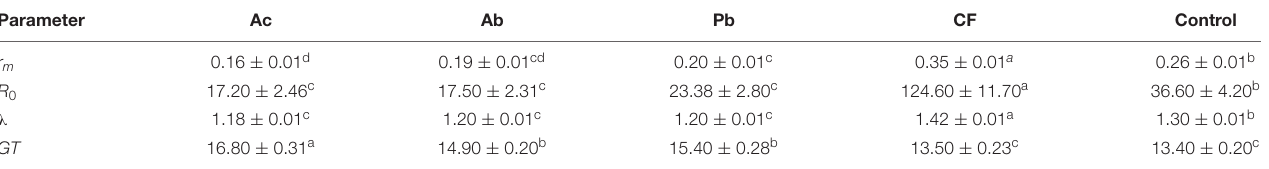
FIGURE 3 | Mean ( ± SE) number of T. urticae (including all mobile developmental stages and adult males and females) per leaf at each weekly sampling interval ( n = 6) on whole strawberry plants receiving one of five treatments, Ac ( Azotobacter chroococcum ), Ab ( Azospirillum brasilense ), Pb ( Pseudomonas brassicacearum ), CF (chemical fertilizer), and control (untreated). TABLE 2 | Mean ( ± SE) demographic parameters of T. urticae calculated using the age-stage, two-sex life table.